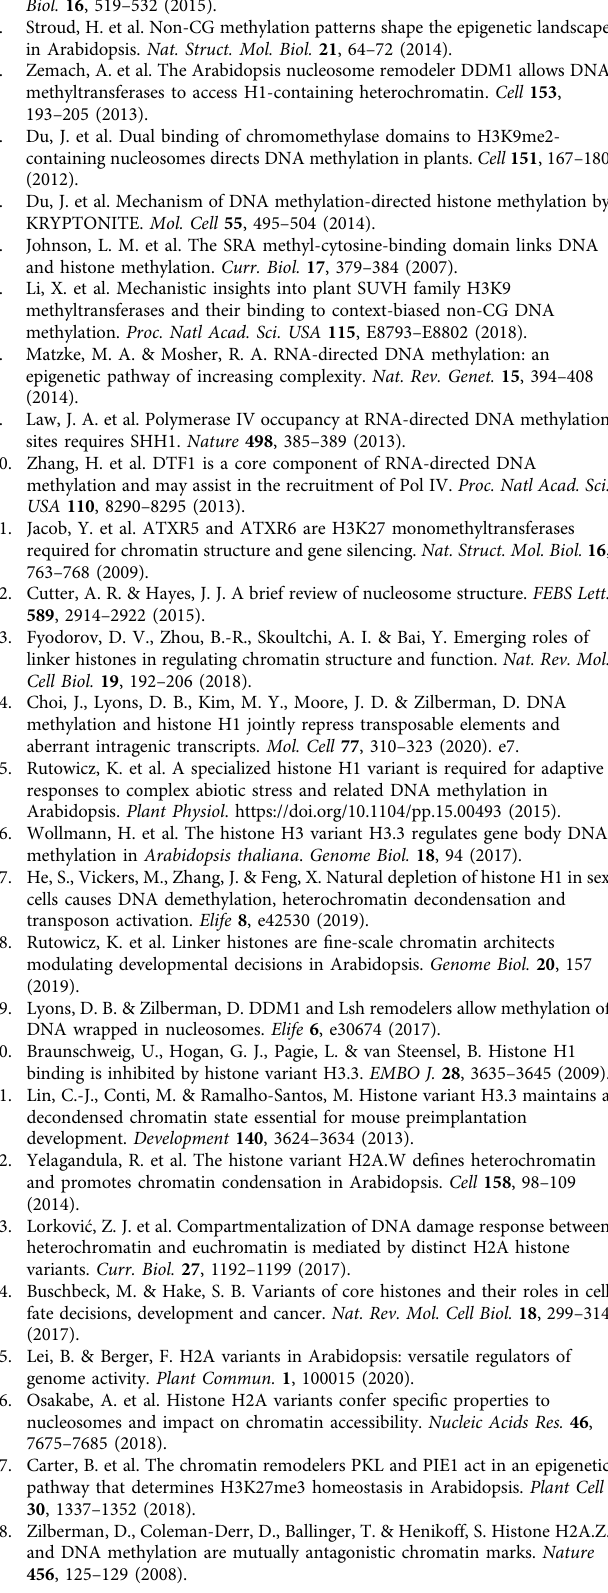
Supplementary Table 4. Sample tracks and peaks in WT and h2a.w-2 were obtained using Genrich 57 with parameters -p 0.01, -a 200, -l 100, and -g 100. ChrM, ChrC, and several rRNA regions with very high coverage were omitted from the analysis. Metaplots of ATAC-seq signal over various genomic regions were created using deeptools 58 . Plots of ATAC-seq signal over entire chromosomes are based on average signal over 1kb non-overlapping bins tiled genome-wide, calculated using deeptools. Smoothed conditional mean of the signal was computed using the LOESS smoothing method with bin width span 0.1 and plotted using R 47 .